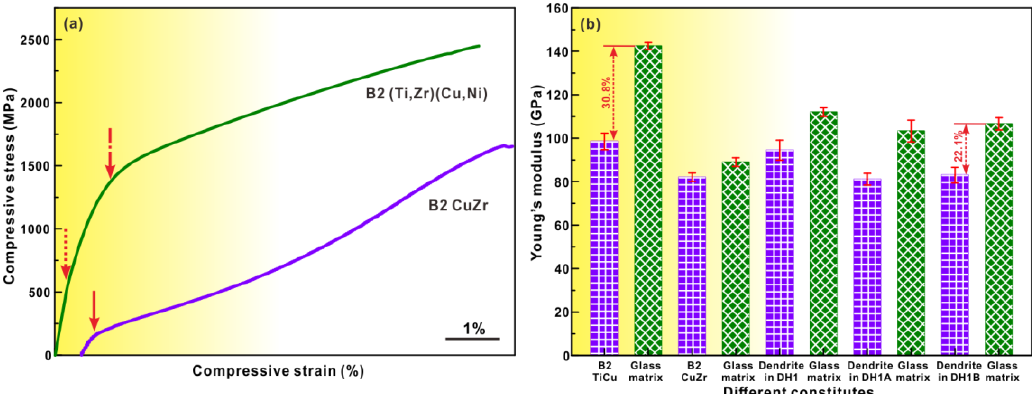
Figure 6. ( a ) The engineering stress-true strain curves under compression of shape memory B2 CuZr crystalline samples for Cu 47.5 Zr 47.5 Al 5 alloys and crystalline B2 (Ti,Zr)(Cu,Ni) specimens in the present work, and ( b ) Young’s moduli of the dispersed particles and the matrix for TiCu-based, CuZr-based [42], and Zr-based BMG composites (i.e., DH1, DH1A, and DH1B) [55].